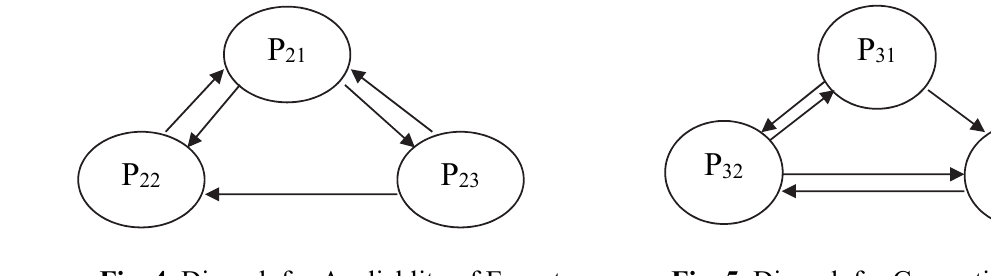
Fig. 4. Digraph for Avaliablity of Experts Fig. 5. Digraph for Competitive advantage